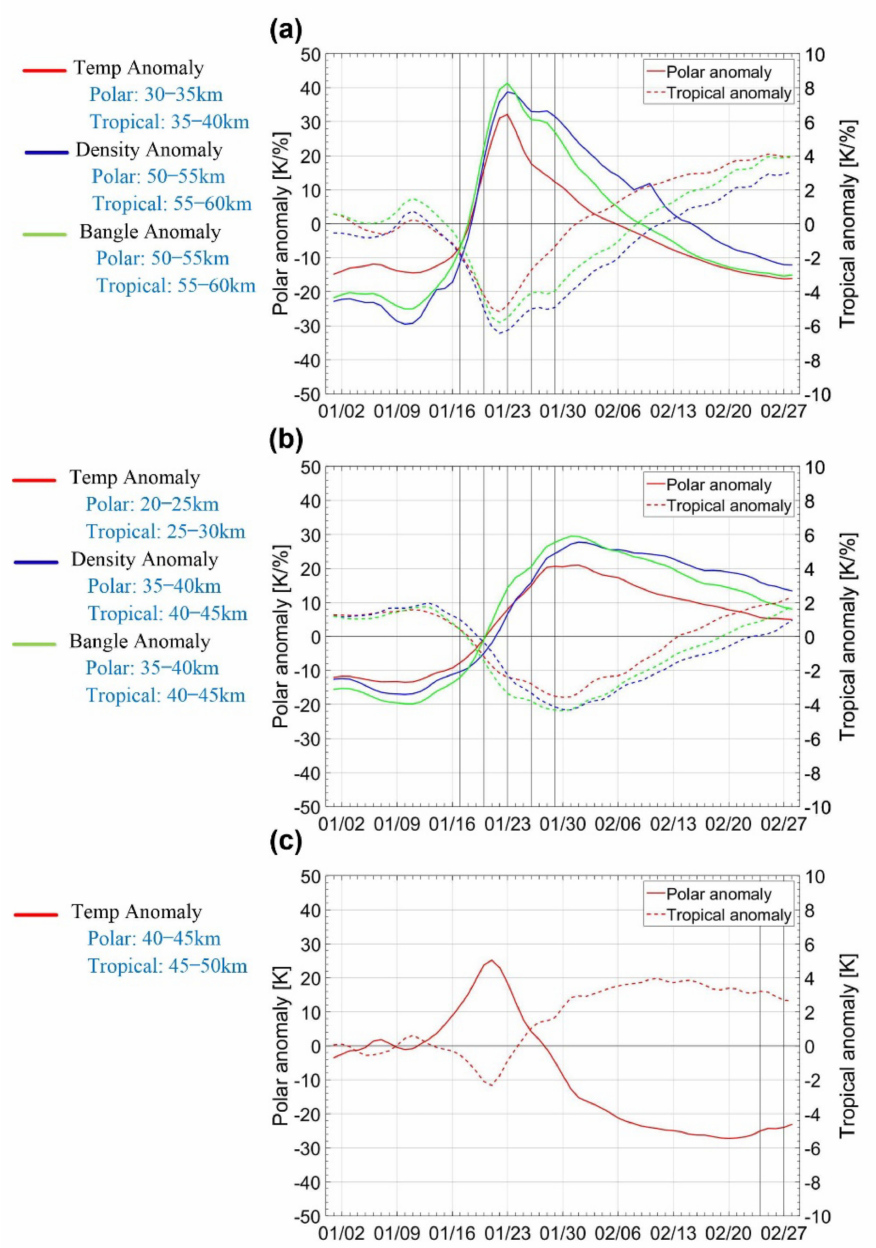
Figure 4. Temporal evolution of RO temperature, density, and bending angle vertical mean anomalies extracted from selected altitude layers of polar and tropical mean anomaly profiles. Panels ( a – c ) show RO anomalies selected from the response, downward, and upward altitude layers respectively. The detail selections of altitude layers for the two regions are described on the left side of each panel and are also indicated with arrows in Figure